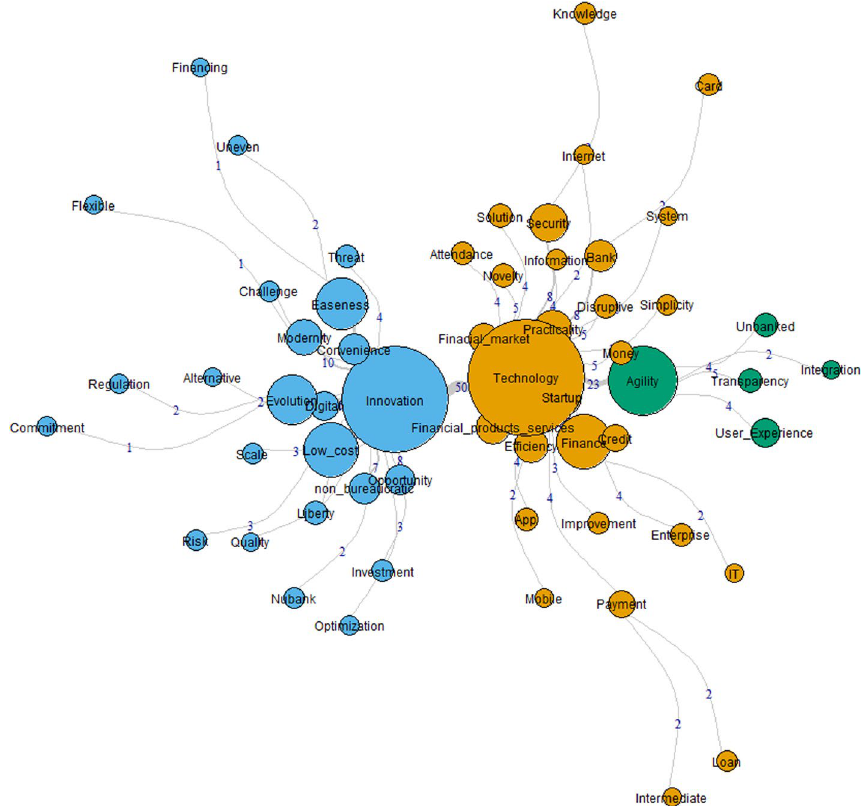
Fig. 3 Maximum similarity tree of the social representation of Fintech